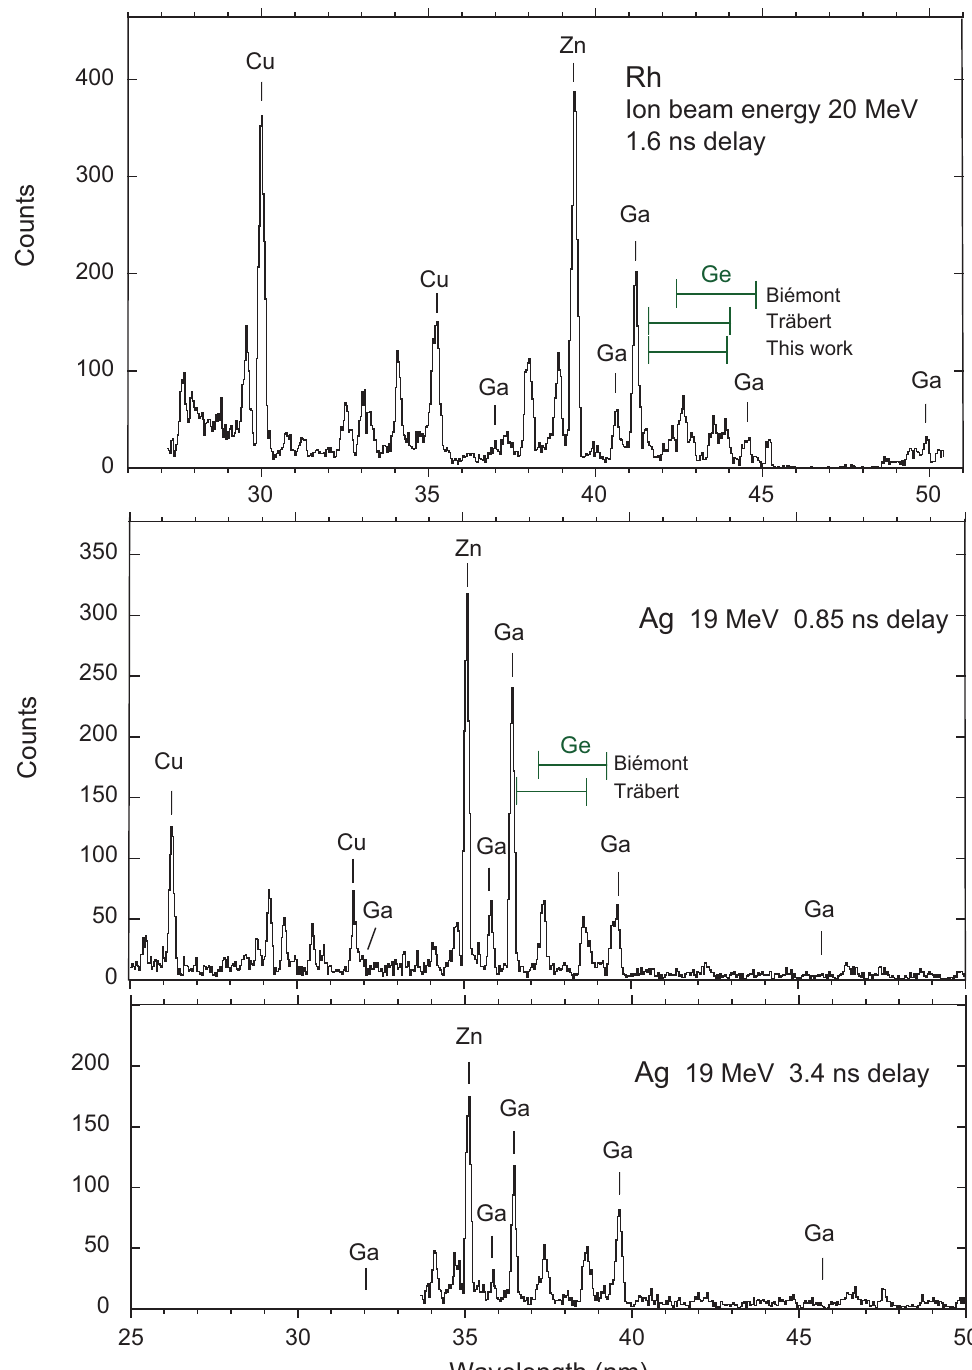
Figure 2. Delayed beam-foil spectra of Rh and Ag in the wavelength range of the Zn-, Ga- and Ge-like ion intercombination lines. Prominent lines are marked by the isoelectronic sequence; the five Ga-like ion intercombination lines are indicated at positions stated by Biémont and Quinet [69], the two intercombination lines in Ge-like ions (green markers) at positions claimed by experiment [52,55] or theory